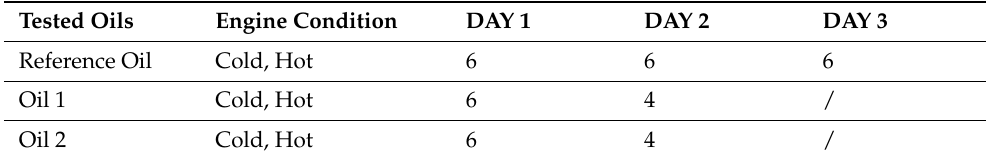
Table 5. Oil test matrix.